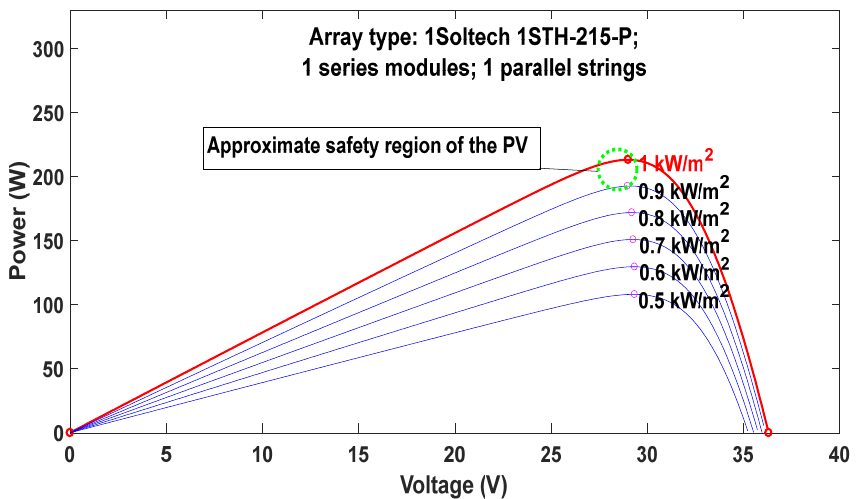
Figure 5. P-V curve under fast-changing climatic conditions for 1STH-215-P. If the PV modules are connected in series and parallel, the safety region is determined by integrating the characteristics of the modules. In a series connection, the safe region is determined using Equation (15).